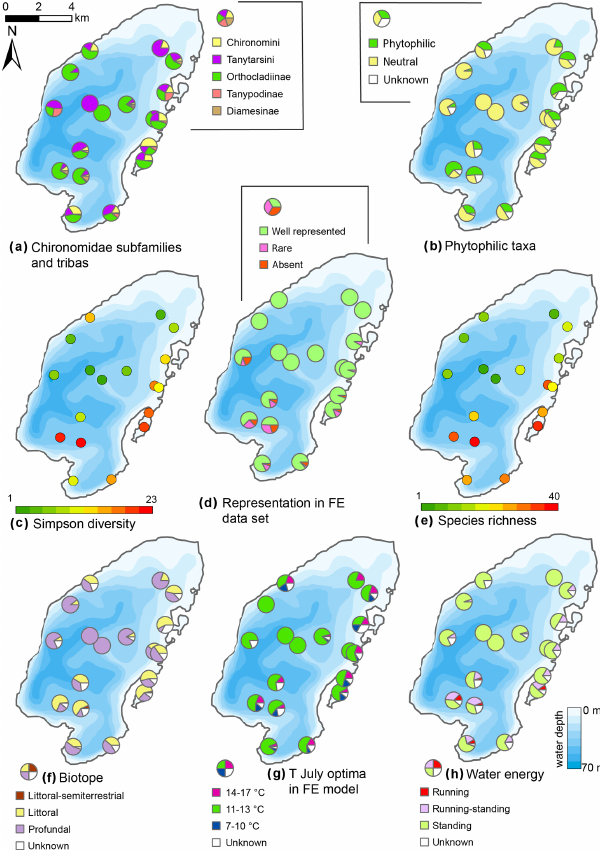
Figure 11. Spatial distribution of chironomid taxa and inferred sta- tistical parameters in the surface sediments of Lake Bolshoe Toko. Maps compiled in ArcGIS 10.4. Scales chosen as 10 classes with equal